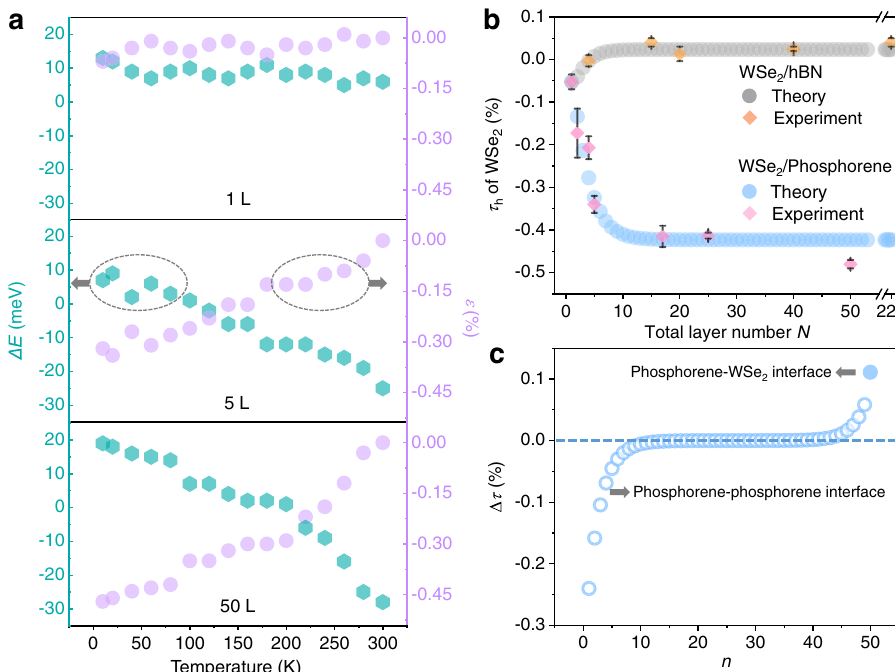
Fig. 4 Extracting STD and ISTD from experiment results and theoretical modelling. a Cyan symbols show the temperature-dependent photon energy difference ( Δ E ) between WSe 2 /phosphorene and isolated WSe 2 at phosphorene layer numbers of 1, 5, and 50, respectively. Violet symbols shows the experimentally measured strain of WSe 2 as a function of temperature. b From 300 to 10 K, experimentally measured and theoretically fi tted STD of WSe 2 ( τ h ) in WSe 2 /phosphorene and WSe 2 /hBN systems with different total layer number N . Here, for each sample, PL signals are collected from at least three spots near the center of heterostructures. The average value (pink/orange symbols) and standard deviation (error bar, black solid line) of τ h ( Ν ) are therefore obtained from the measured Δ E . c Theoretically calculated layer-dependent ISTD ( Δ τ ) in the WSe 2 /50-layer phosphorene/SiO 2 system. Here, the empty circles denote Δ τ at phosphorene-phosphorene interface while the fi lled circle denotes Δ τ at phosphorene-WSe 2